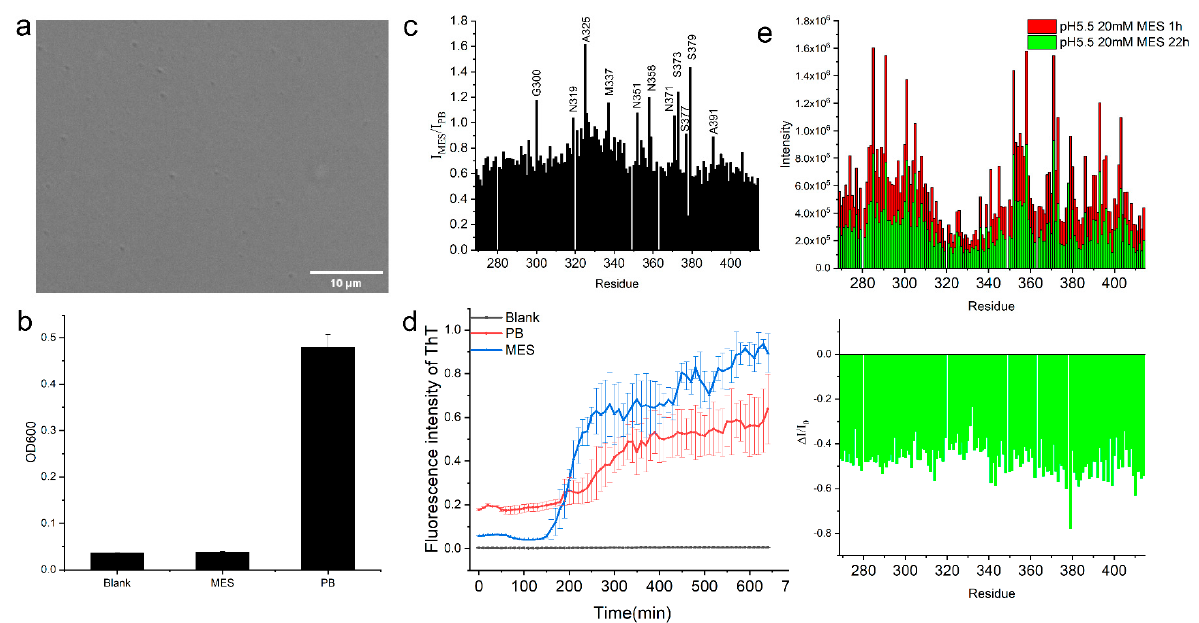
Figure 3. Experiment results on 70 µ M TDP-43 LCD in pH 5.5 MES buffer, the LLPS condition. ( a ) DIC image of TDP-43 LCD in MES buffer. ( b ) OD600 value of 70 µ M TDP-43 LCD in pH 5.5 MES buffer (MES) compared to the blank MES buffer and 100 µ M TDP-43 LCD in pH 6.0 PB buffer (PB). ( c ) Comparison of the NMR signal intensities of 1 H- 15 N HSQC of TDP-43 LCD between the LLPS+ condition (PB) and the LLPS condition (MES). ( d ) THT fluorescence changes of TDP-43 LCD in two different conditions (PB vs. MES). ( e ) (Top) Comparison of the NMR signal intensity from 1 H- 15 N HSQC spectra of TDP-43 LCD in the LLP condition in MES (labeled as I 1h using the time approximate in the middle of the experiment, in red) and obtained at ~22 h (I 22h , in green) from the sample preparation. (Bottom) NMR signal loss ratio ( ∆ I/I 1h ) over time, where ∆ I represents the NMR signal intensity after 22 h minus I 1h .